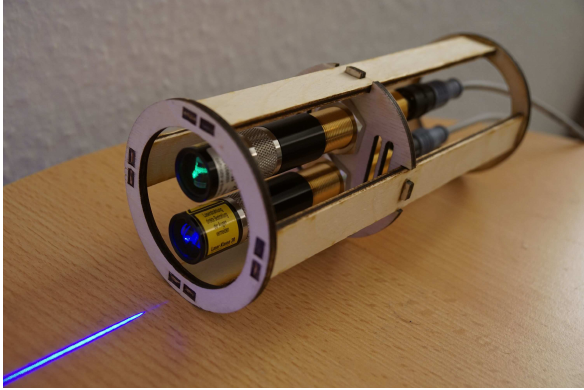
Figure 6: Cross line laser projector in wooden frame employed for the